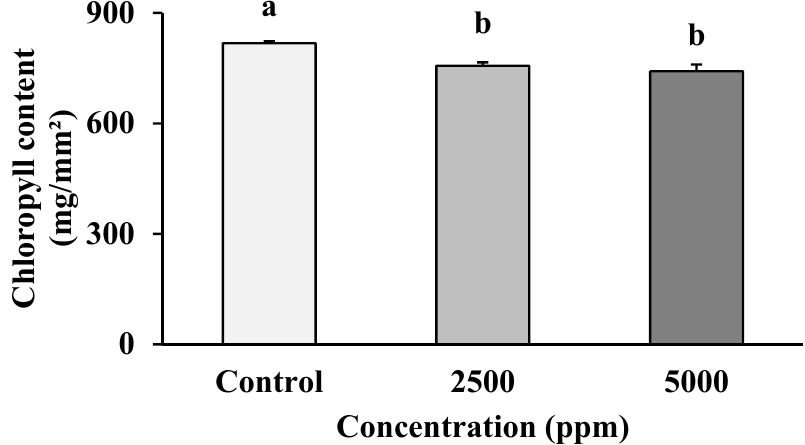
Figure 4. Effect of SCE treatment on the growth of Festuca arundinacea.